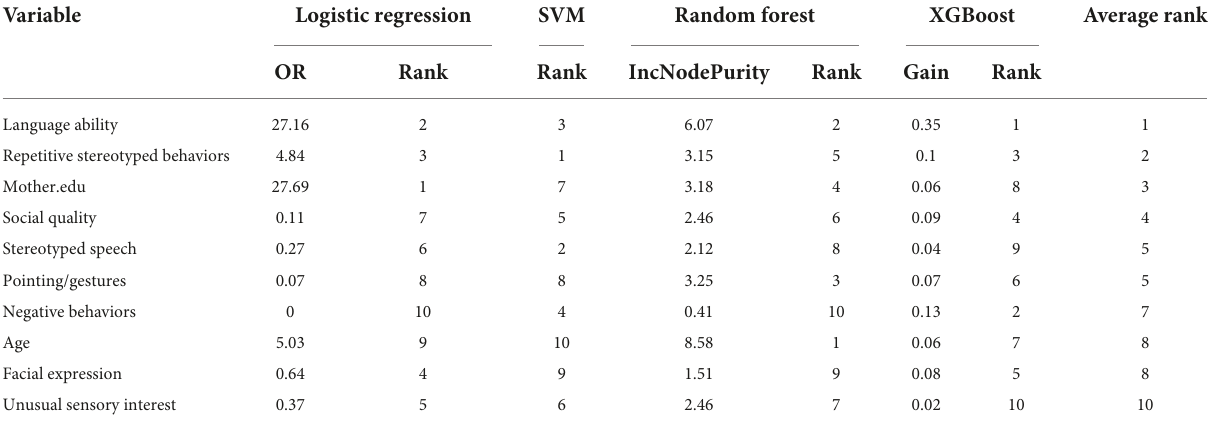
TABLE 7 Variable importance order of LR, SVM, RF, and